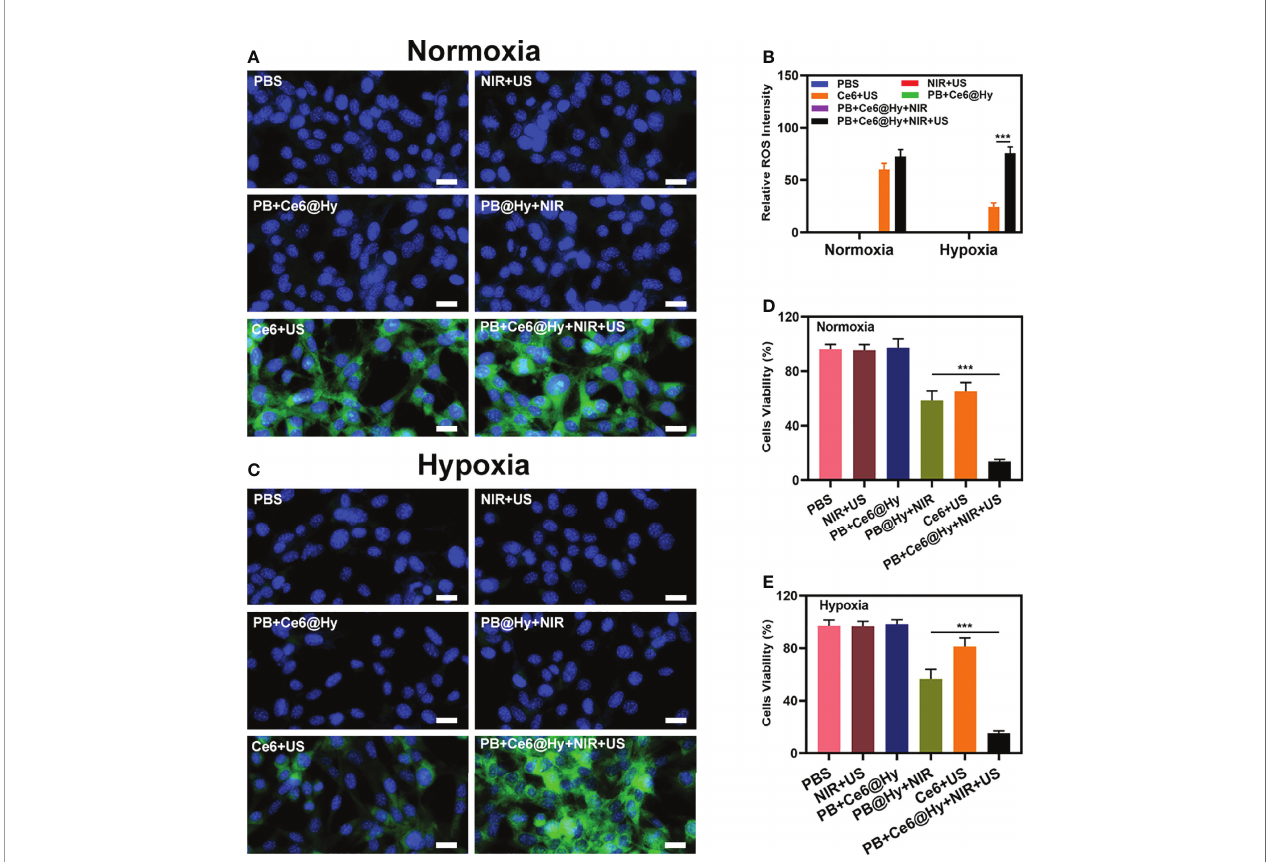
FIGURE 2 | Results of in vitro experiments. Fluorescence microscopy images of DCFH-DA to detect intracellular ROS with various treatments under normoxic (A) and hypoxia (C) condition. Scale bar = 20 m m. (B) DCFH-DA fl uorescence intensity after the indicated treatments. (D) Cell viability of 4T1 cells cultured in the presence of various formulations under normoxic condition. (E) Cell viability of 4T1 cells cultured in the presence of various formulations under hypoxia condition. ***P < 0.005; Student ’ s